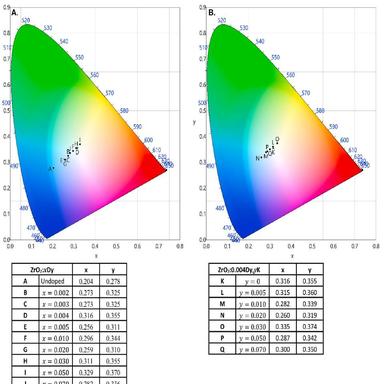
The CIE chromaticity coordinate diagram of ZrO2:xDy3+ and ZrO2:0.004Dy3+, xK + phosphors excited at 349 nm.